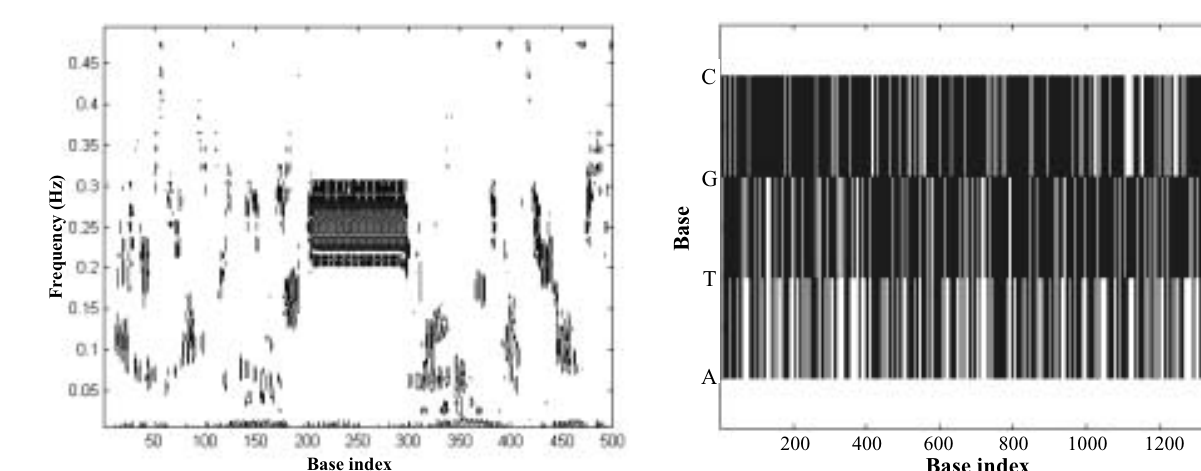
Figure 8 Mapping value for the non-repetitive base ‘G’ at the frequency of 0.25Hz.